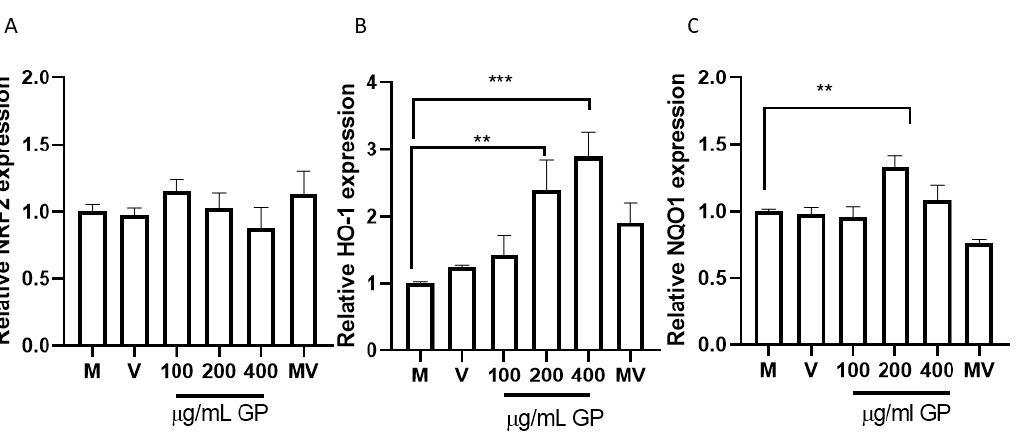
Figure 3. Expression of antioxidant genes, by RT-qPCR, in response to different concentrations of grape pomace (GP). ( A ) Relative NRF2 expression; ( B ) Relative HO-1 expression; ( C ) Relative NQO1 expression. Results are presented as mean ± SEM ( n = 3). ** p < 0.005, *** p < 0.0005. M (cells without treatment); V (DMSO ˂ 0.1%) and MV (Malvidin 3-glu). RPL30 was used as normalizer.